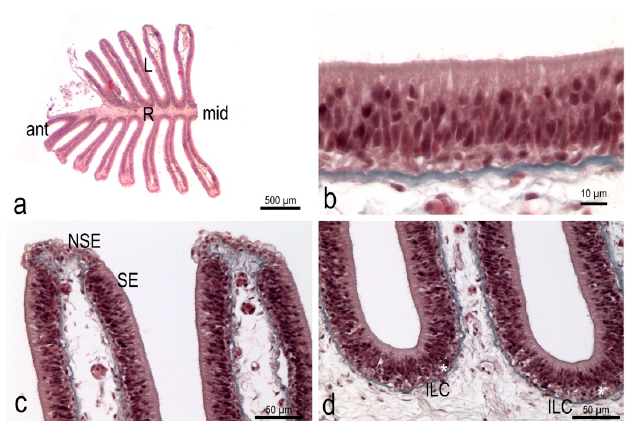
Figure 4. Histology of the olfactory rosette of P. antarcticum . ( a ) Hematoxylin-Eosin of the anterior half of an olfactory rosette. The cutting plane is parallel to the dorsal surface of the rosette, as seen in Figure 2b. ( b ) Masson’s Trichrome; detail of the sensory epithelium along the lamellae surface. ( c ) Masson’s Trichrome; apical part of two lamellae. The sensory epithelium covers the lamellae and only the free edge of each lamella shows a different, non-sensory epithelium. The connective tissue of the lamina propria is quite loose, and the blue of the collagen—indicating a more compact tis- sue—runs in a thin layer just under the basal lamina. ( d ) Masson’s Trichrome; basal part of two lamellae and one interlamellar curve. The basal layer of the sensory epithelium, in the interlamellar curve, is thicker than along the lamellae and shows at least two layers of round nuclei (asterisk). ant = anterior part of the rosette; ILC = interlamellar curve; L = lamella; mid = middle part of the rosette in an anterior-posterior direction; NSE = non-sensory epithelium; R = raphe; SE = sensory epithe- lium.